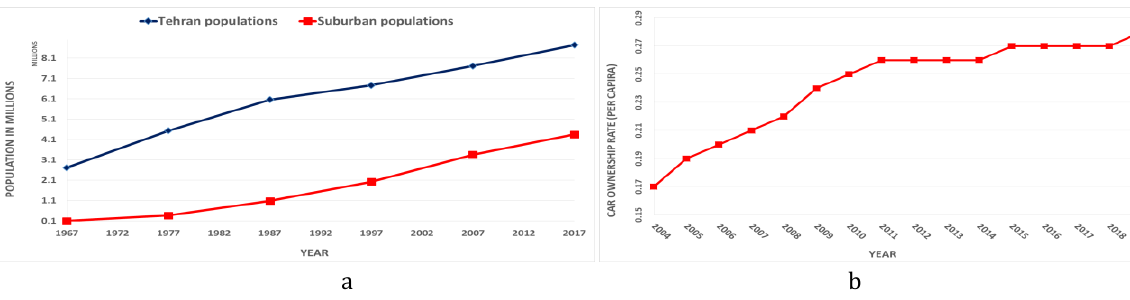
Figure 1: a) Population trend of Tehran and its suburbs, b) Car ownership rate trend in Tehran